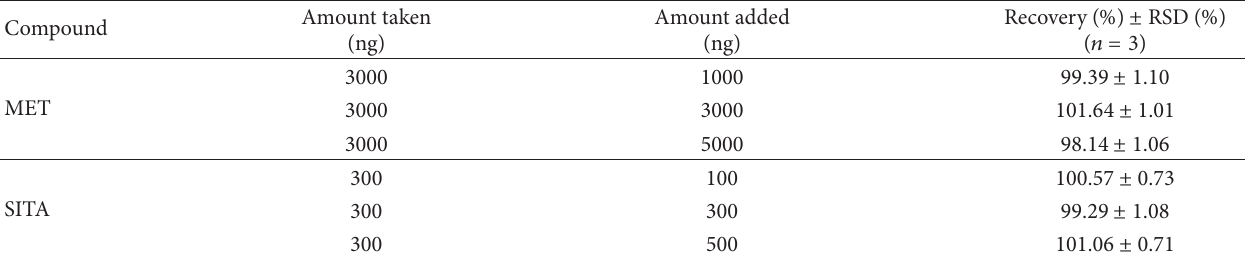
T 2: e recovery studies of MET and